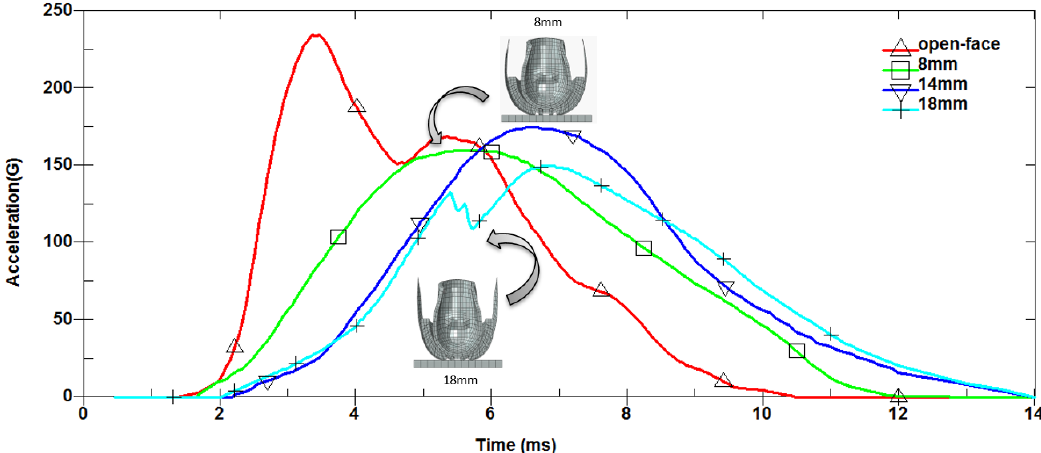
Figure 9. Simulated headform acceleration profiles for the open-face helmet and prototype open-face helmet with three different ventilation slot widths.